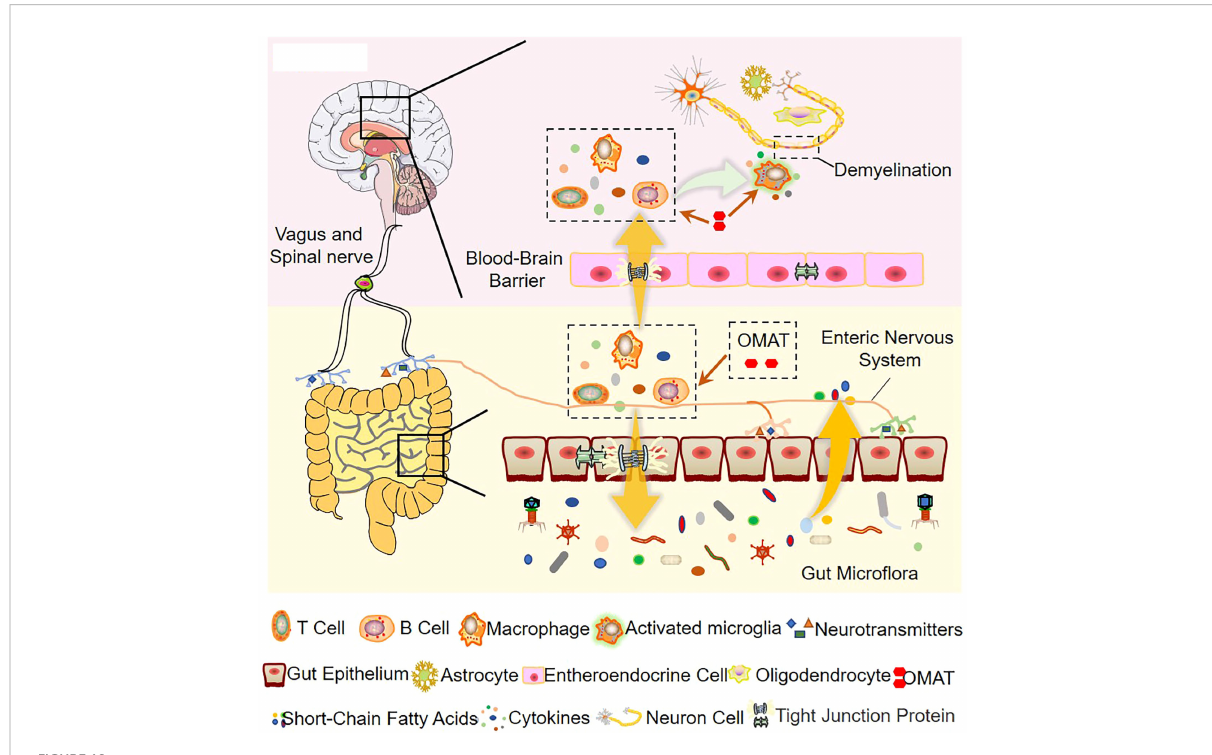
FIGURE 10 The role of OMAT on interfering with the progression of multiple sclerosis through the brain-gut